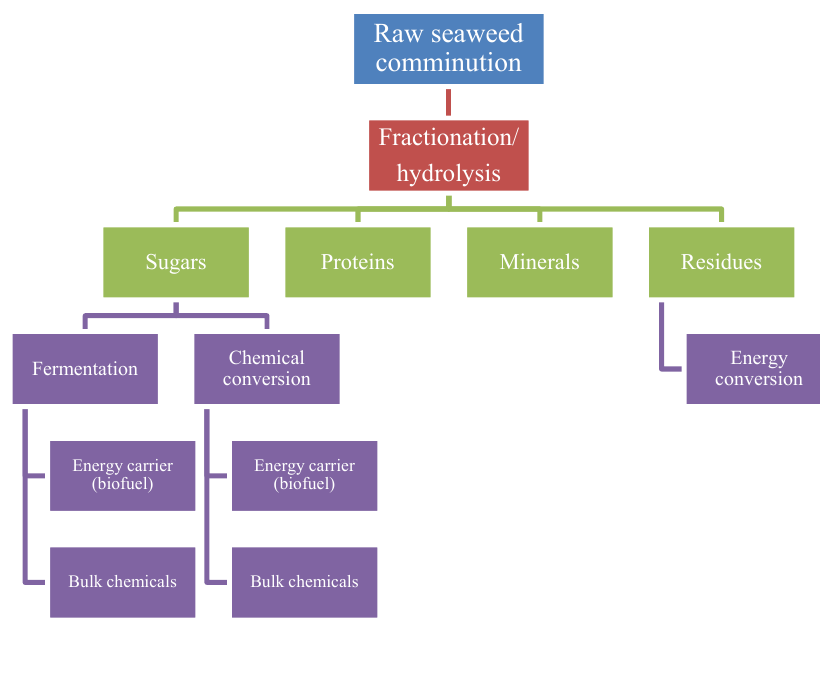
Figure 4. Macroalgae biorefinery concept, adapted from